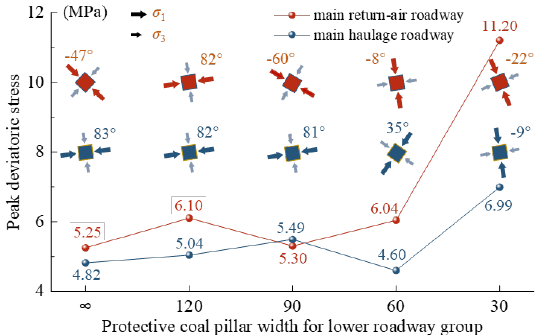
Figure 13. Stress distribution of the main roadway group in the lower coal seam.